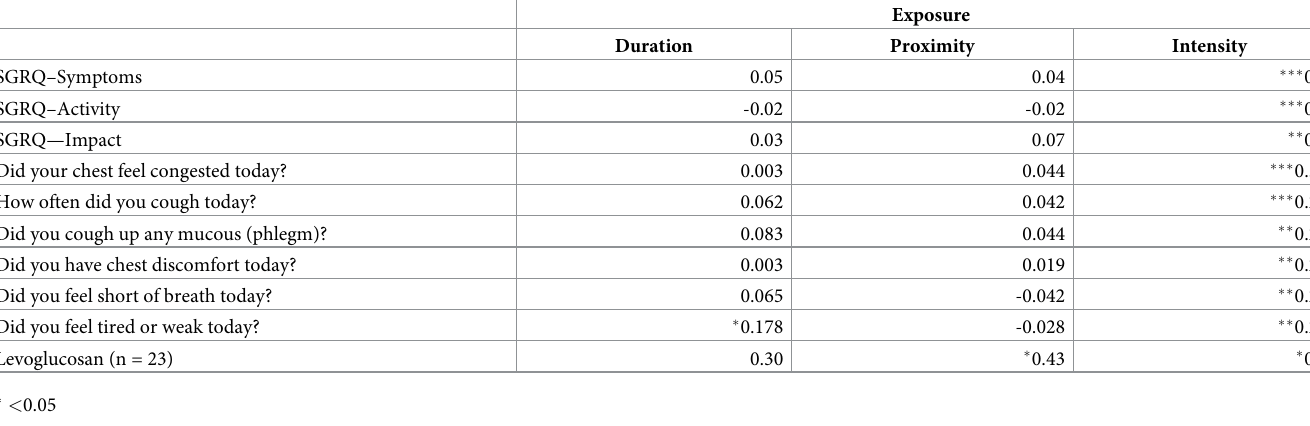
Table 6. Correlations with SGRQ, baseline daily symptom report, and in-home measures of